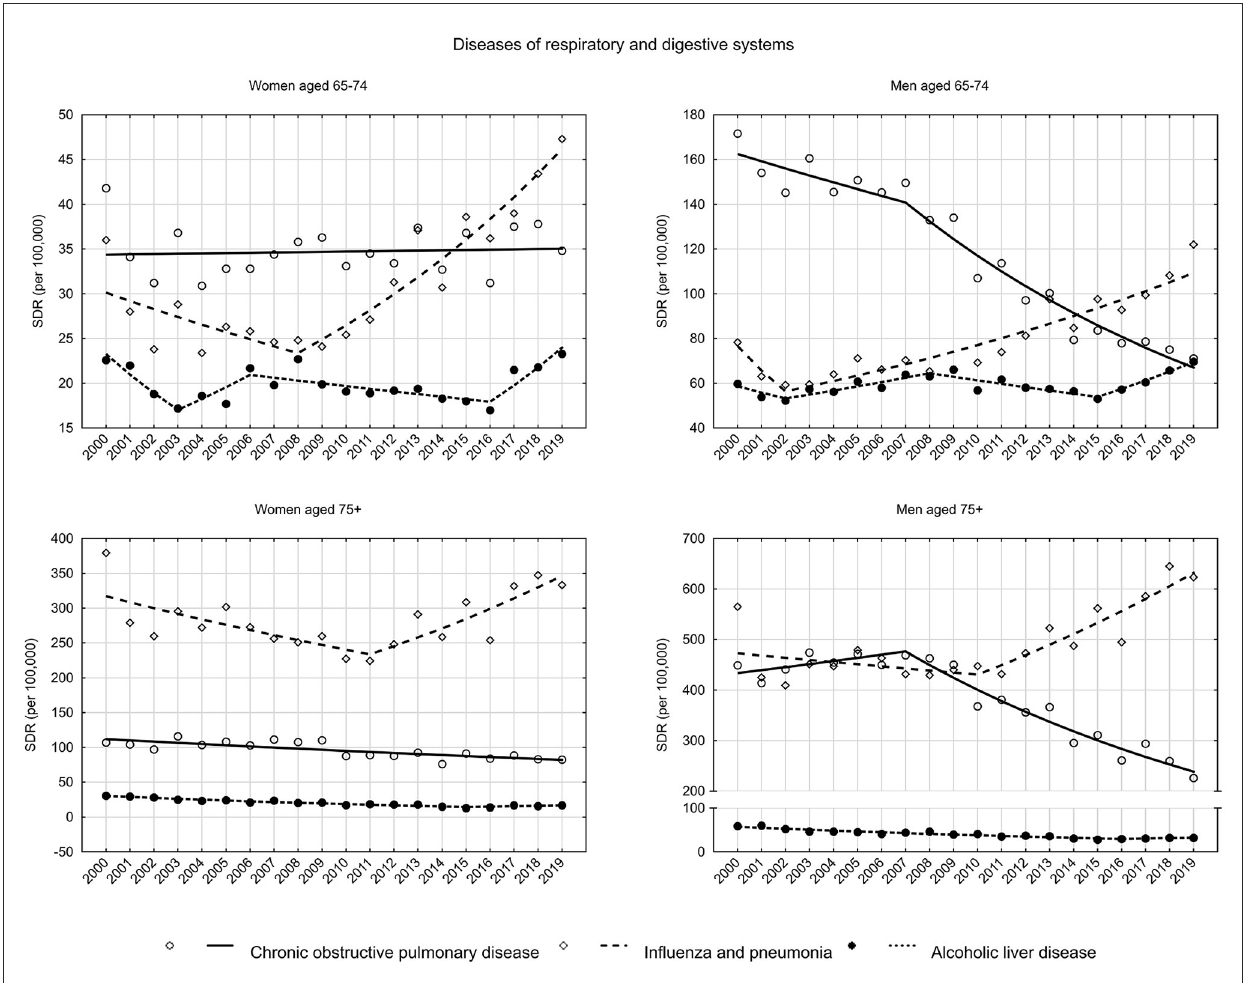
FIGURE4 SDR trends in the Polish population aged 65–74 years and 75 years and older due to diseases of the respiratory and digestive system in the years 2000–2019.